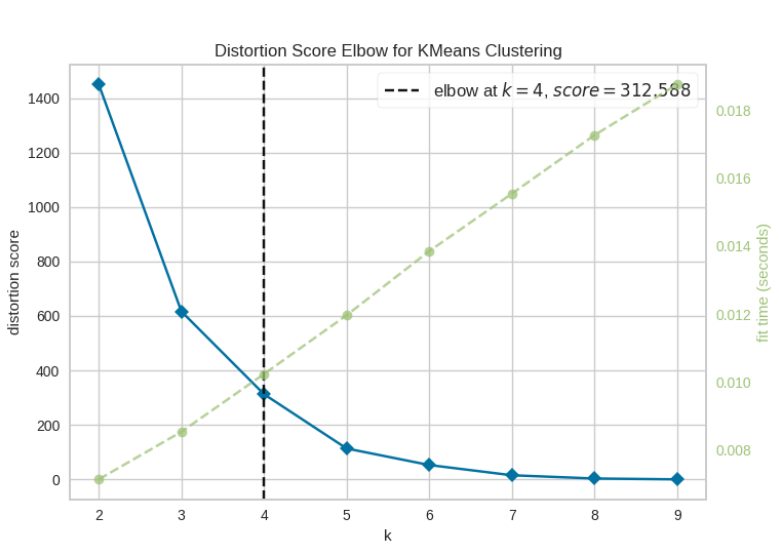
Figure 3. Example of a plot demonstrating the elbow method. The distortion score is computed as the sum of squared distances from each point to its assigned centre. In this case, the number of selected clusters should be